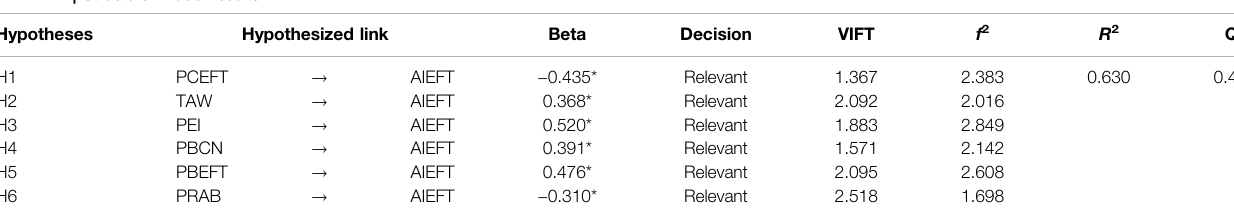
TABLE 4 | Structural model